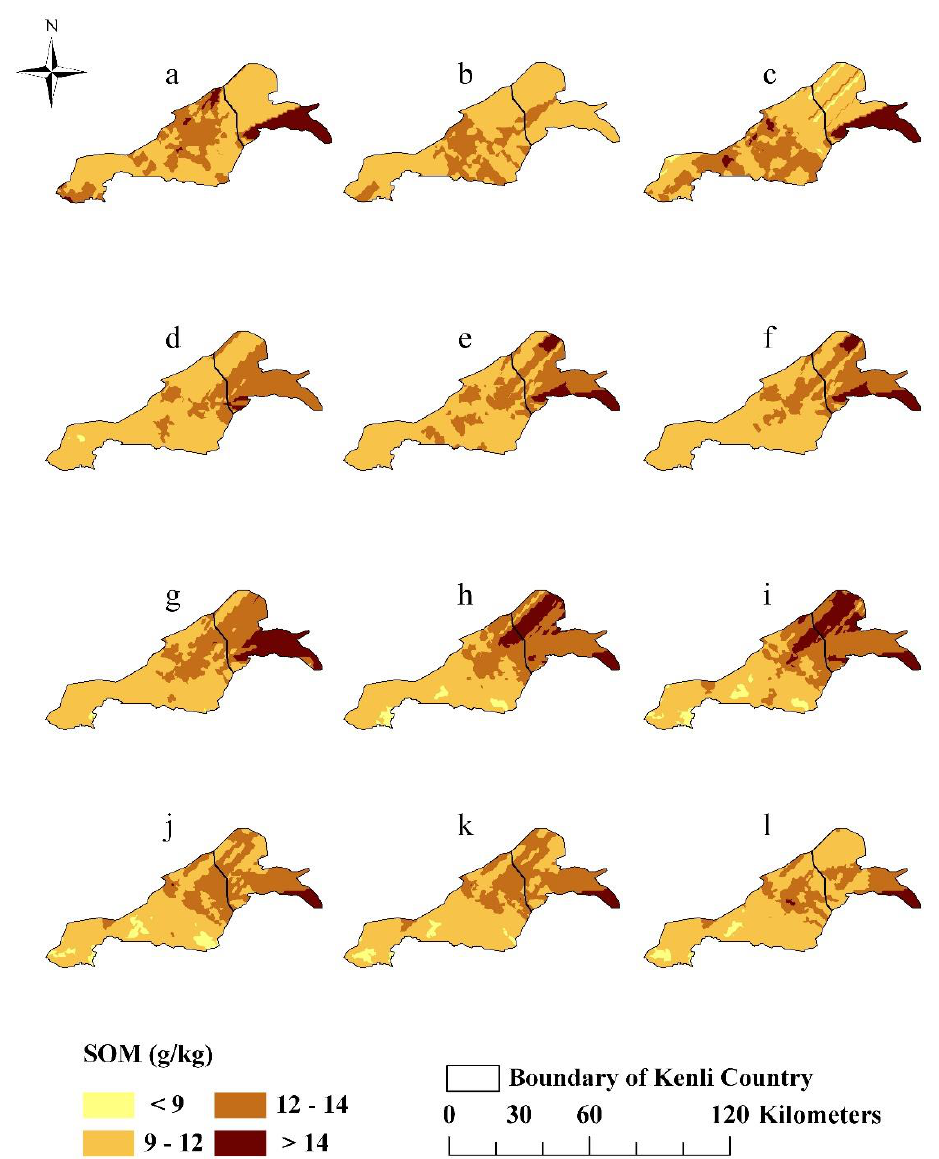
Figure 4. Spatial distribution of the SOM content under 12 sampling-point sets in Kenli County. Note: The number of sampling point sets represented by ( a – l ) is 50, 75, 100, 150, 200, 300, 400, 500, 600, 700, 800 and 900,